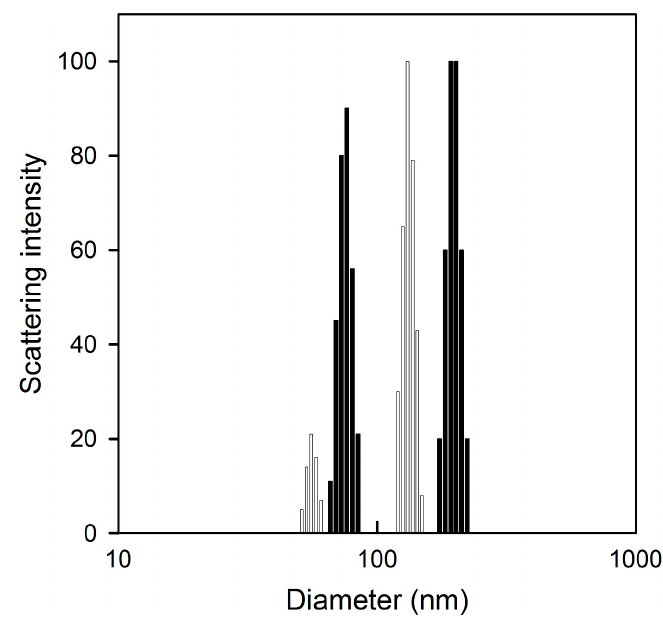
Figure 2. Representative size distribution profiles by dynamic light scattering considering the light intensity of Cis-Ls (grey) and Cis-MLs (black).